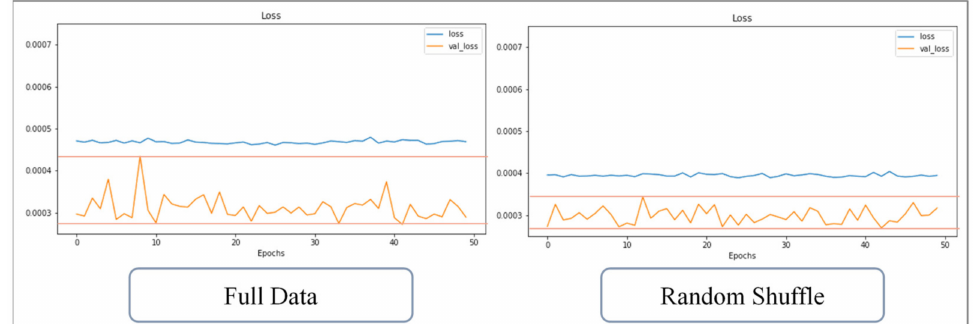
Figure 18. Change of loss value with or without random shuffle (200 runs).